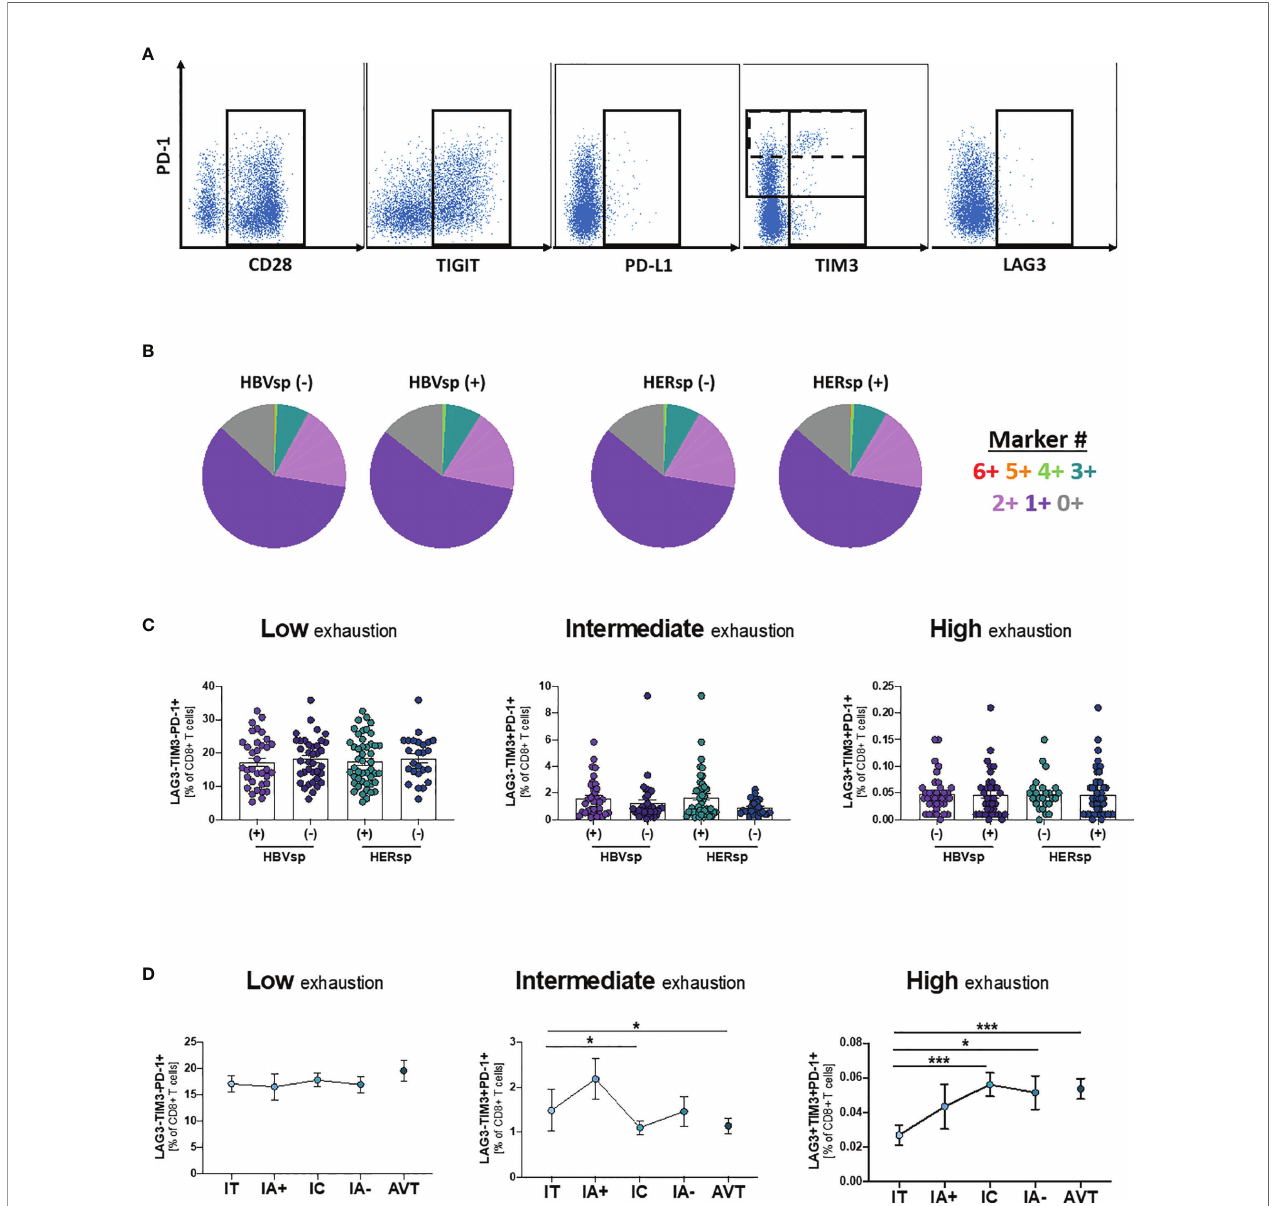
FIGURE 2 | Ex-vivo Ag-speci fi c reactivity does not associate with bulk CD8 T cell exhaustion levels. (A) Representative fl ow plots showing expression levels, on bulk CD8 T cells, of inhibitory (iR) and activating (aR) receptors included in the SPICE analysis. (B) SPICE analysis showing the distribution of marker co-expression ( 6 + markers for CD28+PD-1+TIGIT+PD-L1+TIM3+LAG3+) among patients with either HBV-speci fi c reactivity (core and/or pool, left panel) or HERPES-speci fi c reactivity (CMV and/or EBV, right panel). Frequency of CD8 T cells with phenotype consistent with low exhaustion (LAG3-TIM3-PD-1+, left panel), intermediate exhaustion (LAG3-TIM3+PD-1+, middle panel) or high exhaustion (LAG3+TIM3+PD-1+, right panel) (C) among patients with either HBV-speci fi c reactivity (core and/or pool) or HERPES-speci fi c reactivity (CMV and/or EBV) and (D) among the different clinical groups. IT, Immune Tolerant; IA+, HBeAg+ Immune Active; IC, Immune Control; IA-, HBeAg- Immune Active; AVT, Anti-Viral Therapy. *p < 0.05; ***p <